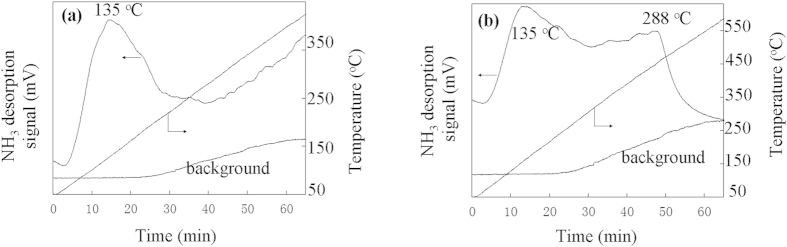
NH3-TPD curves of magnetic carbonaceous acid: (a) before sulfonation (C/Fe3O4, acidity of 0.17 mmol g−1) and (b) after sulfonation (C-SO3H/Fe3O4, acidity of 0.96 mmol g−1) (background without NH3).